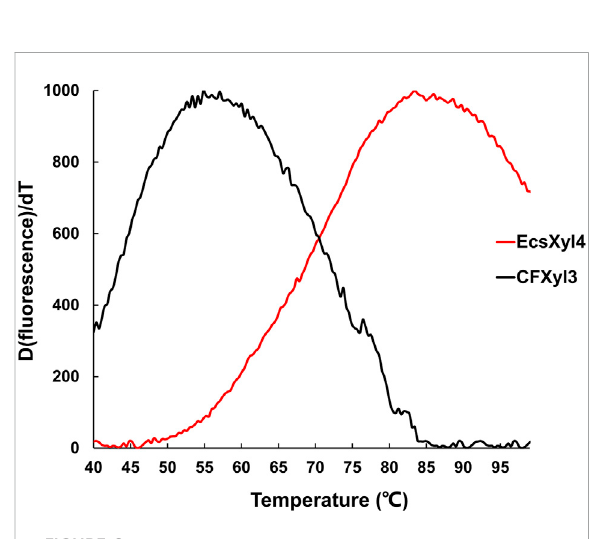
FIGURE 6 Derivative melting curves of CFXyl3 ( black ) and EcsXyl4 ( red ). The emission intensity of the fl uorescence dye was recorded from 40 to 99 ° C at an elevated rate of 1 ° C min − 1